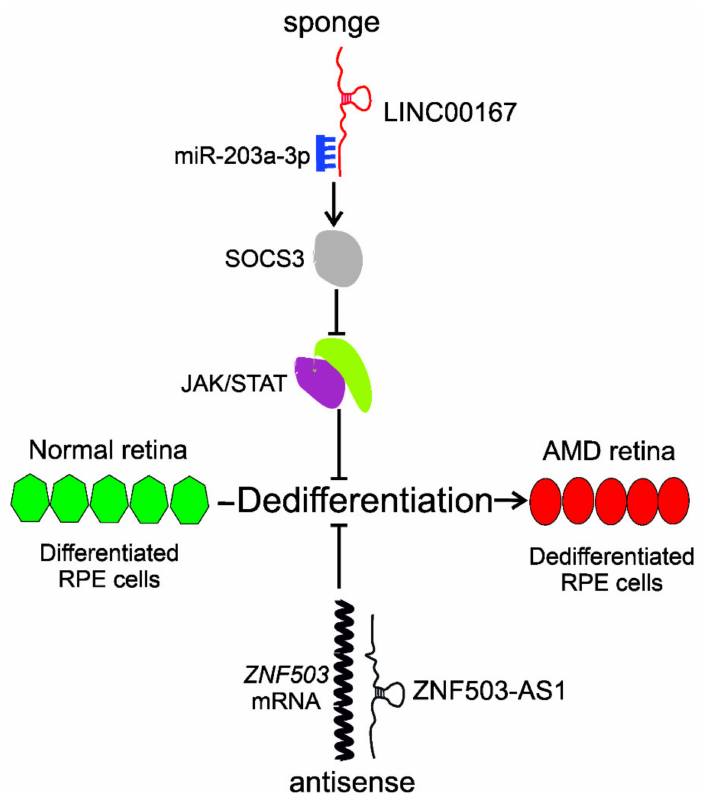
Figure 4. Long non-coding RNAs (lncRNAs) ZNF503-AS1 (zinc finger protein 503 antisense RNA 2) and LINC00167 inhibit the dedifferentiation of retinal pigment epithelium (RPE) cells, important in age-related macular degeneration (AMD). These lncRNAs act as an antisense inhibitor and sponge for micro RNAs, respectively. ZNF503-AS1 targets mRNA of the ZNF503 gene as it has a complementary sequence and prevents its translation resulting in the inhibition of dedifferentiation of RPE